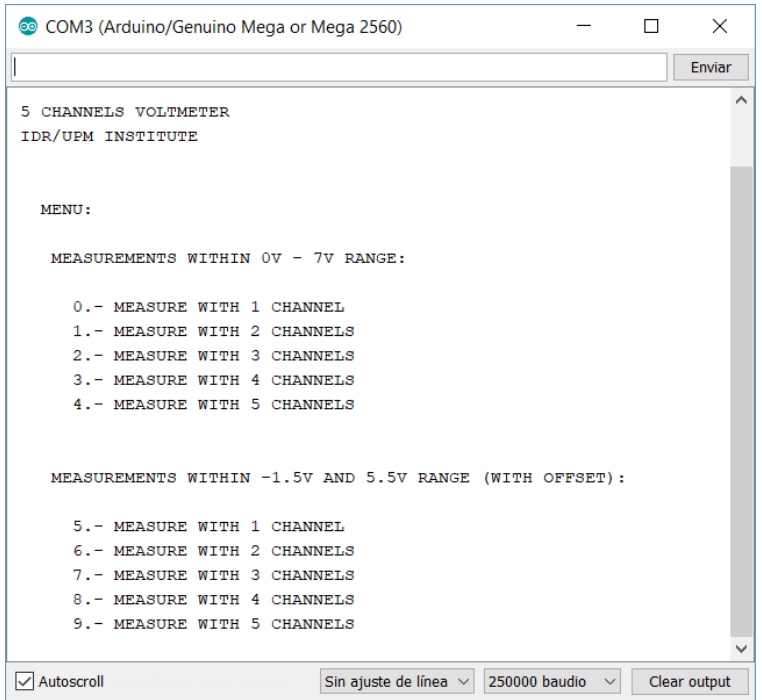
Figure 7. Serial monitor window of ABDAS.